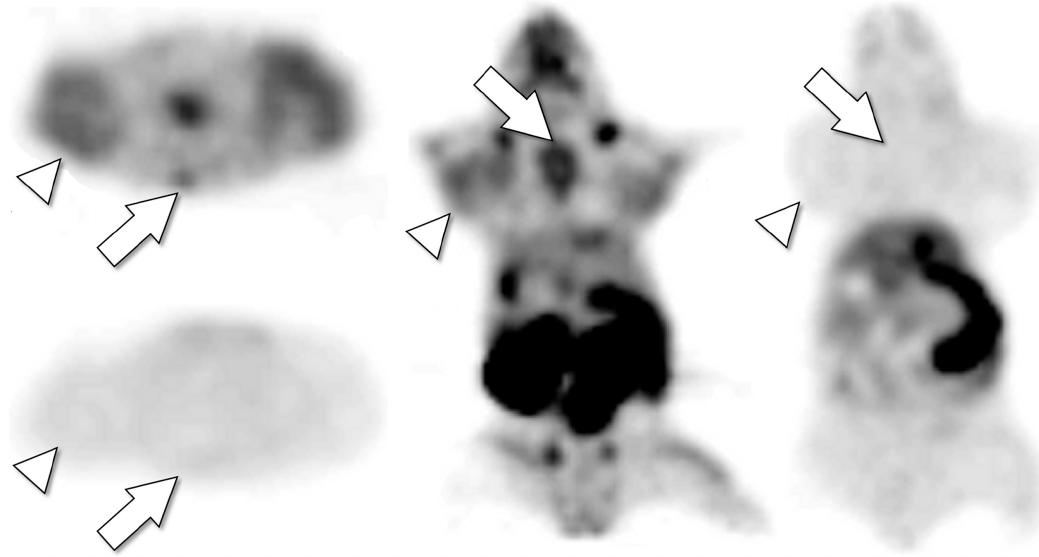
Figure 3. Drug tracer imaging can detect tumor saturation by therapeutic drug. Axial (left top, left bottom) and coronal (middle, right) PET images of single mouse bearing tumors after IV injection with F-18 SKI249380, radiolabeled analogue of therapeutic tyrosine kinase inhibitor dasatinib. Microdose (radiotracer only) images (left top, middle) detect avid tumors ( arrowheads , H1975 lung cancer xenograft) and bone marrow (e.g., sternum, arrows ). The next day (after F-18 isotope decay), the mouse was re-imaged after receiving F-18 SKI249380 radiotracer co-injected with therapeutic dose of dasatinib (left bottom, right). The therapeutic dasatinib dose competitively inhibited uptake of the radiotracer in tumors and bone marrow, indicating that the drug and tracer share the same in vivo tumor pharmacokinetic pathways and that these drug-specific tumor pharmacokinetic pathways (cellular kinase targets and / or pre-target uptake and transport mechanisms) were saturated by the single therapeutic dose. The tumor-saturating dose used in the animal model (30 mg / kg) was equivalent (by allometric extrapolation) to a 140 mg human dose, less than the maximum tolerated dose of some solid tumor dasatinib therapy trials